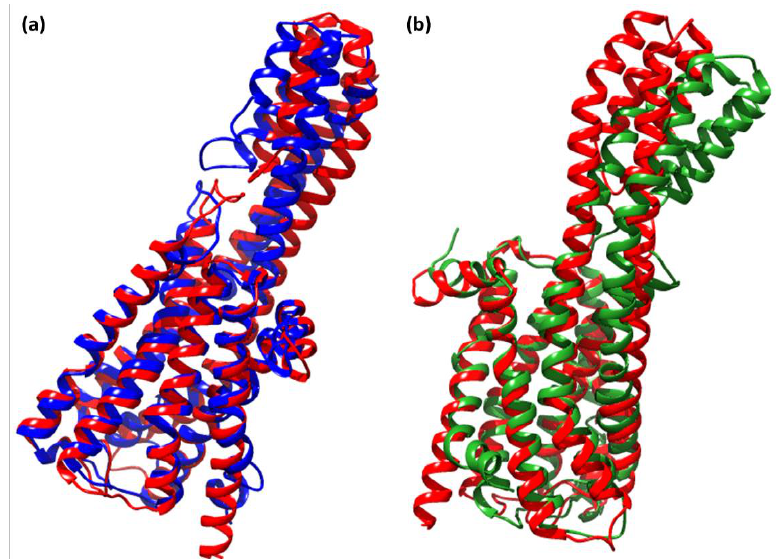
Figure 12. Superimposed structures of ( a ) unbound serotonin receptor (red) and serotonin receptor after simulation (blue) for the RisS complex, and ( b ) unbound serotonin receptor (red) and serotonin receptor after simulation (green) for the CTcS complex.